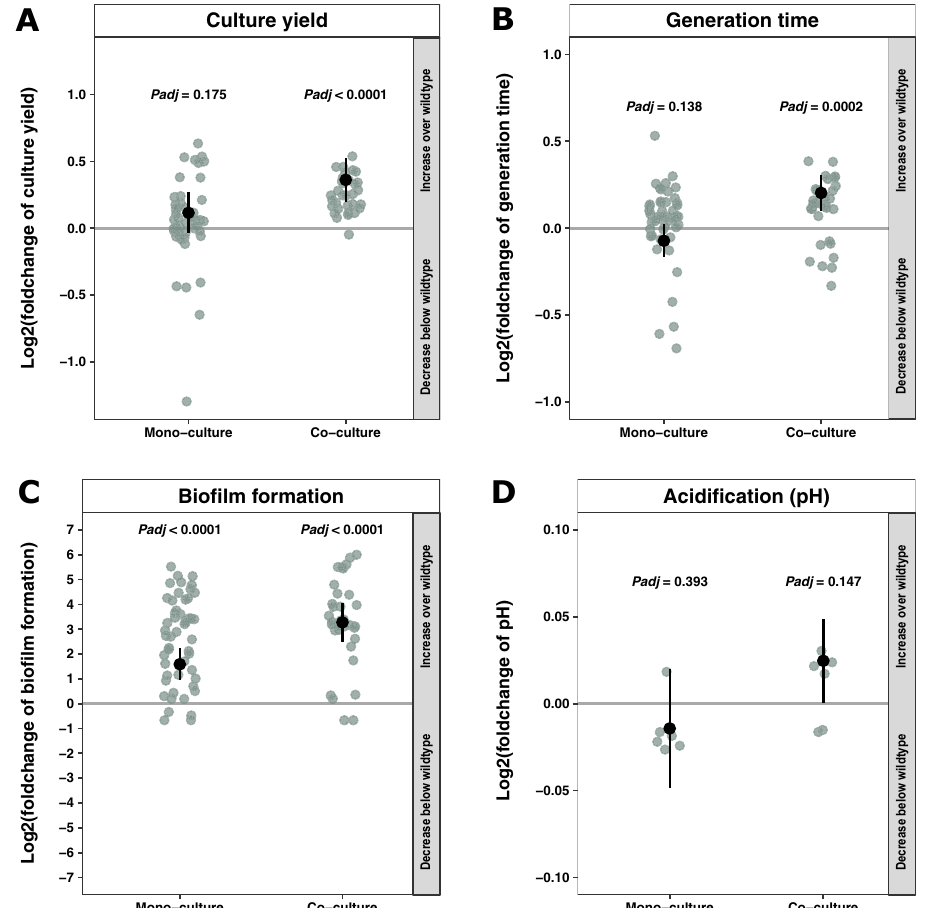
Fig. 3 Co-cultivation increased culture yield, generation time, bio fi lm formation and fi nal pH of Lactococcus lactis isolates. A Comparative analyses of L. lactis isolates emerging from mono- and co-cultivation, respectively, revealed that co-cultivation enabled unique evolution of isolates with signi fi cantly increased culture yield compared to the ancestor ( P adj < 0.0001, MELM). Culture yield of all mono- and co-culture isolates was normalized to the culture yield of the ancestor. B Comparison of generation times from growth-monitored cultures of ancestor, mono- and co-culture isolates of L. lactis , based on OD 600 measurements and the Growthcurver package. The increased generation time was unique for the co-culture isolates ( P adj = 0.0002, MELM). Growth rates of all mono- and co-culture isolates were normalized to the generation time of the ancestor. C Comparison of bio fi lm formation under static conditions in the Calgary device using crystal violet to assess bio fi lm formation after 48 h of growth. Both mono- and co-culture isolates formed signi fi cantly more bio fi lm than the ancestor ( P adj < 0.0001, for both, MELM). D Comparison of fi nal pH level in spent medium after 24 h of growth in a subset of isolates. No signi fi cant differences in pH development were detected in the tested isolates compared to the ancestor ( P adj = 0.393 and 0.147, MELM). Differences between mono- and co-culture isolates and the ancestor were assessed with a mixed-effects linear model. One observation represents the average of four biological replicates for culture yield and generation time ( A , B , N = 79), while one observation represents the average of three biological replicates for bio fi lm formation and acidi fi cation ( C , D , N = 85 and 12, respectively). Black symbols represent estimated population mean by MELM, error bars represent 95% con fi dence intervals and green dots represent observations. P values are adjusted using